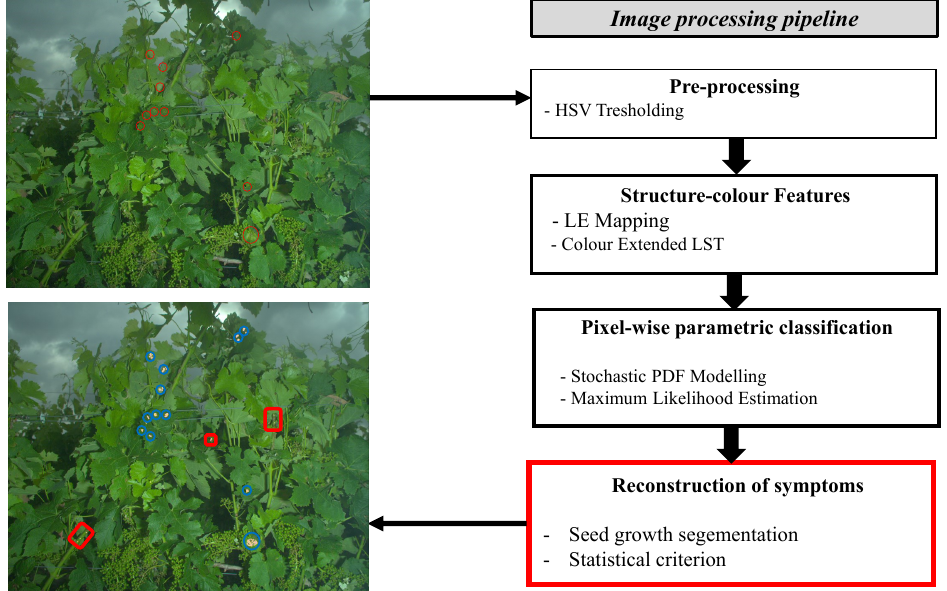
Figure 3. Image processing pipeline for the reconstruction of downy mildew foliar